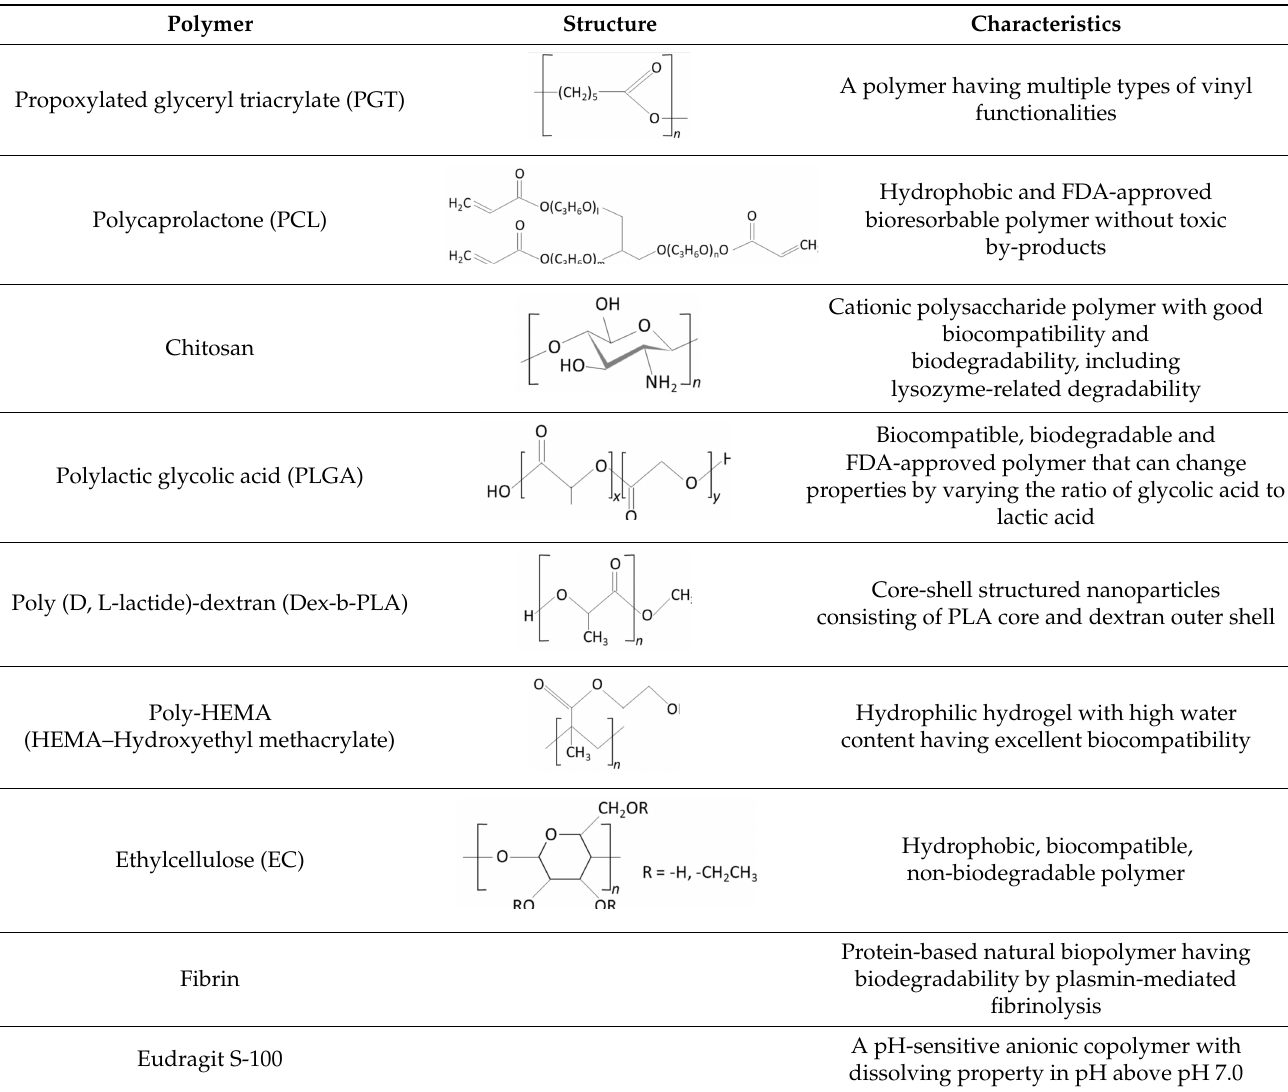
Table 2. Characteristics of various polymers as vehicles for therapeutic contact lenses